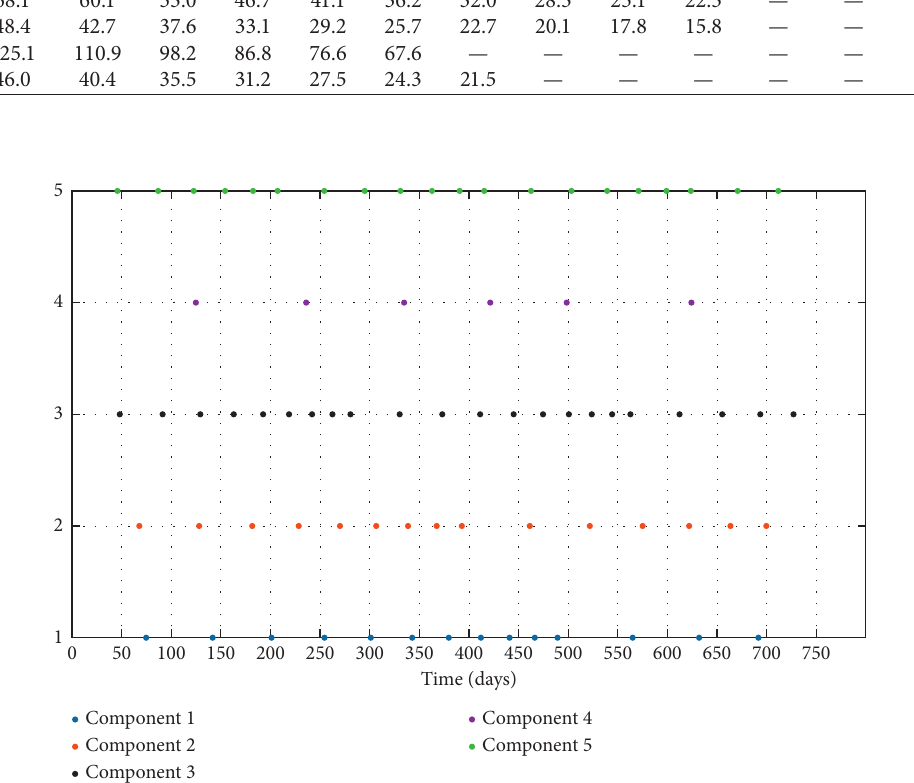
Figure 8: The optimal PM plan for each component of the drive